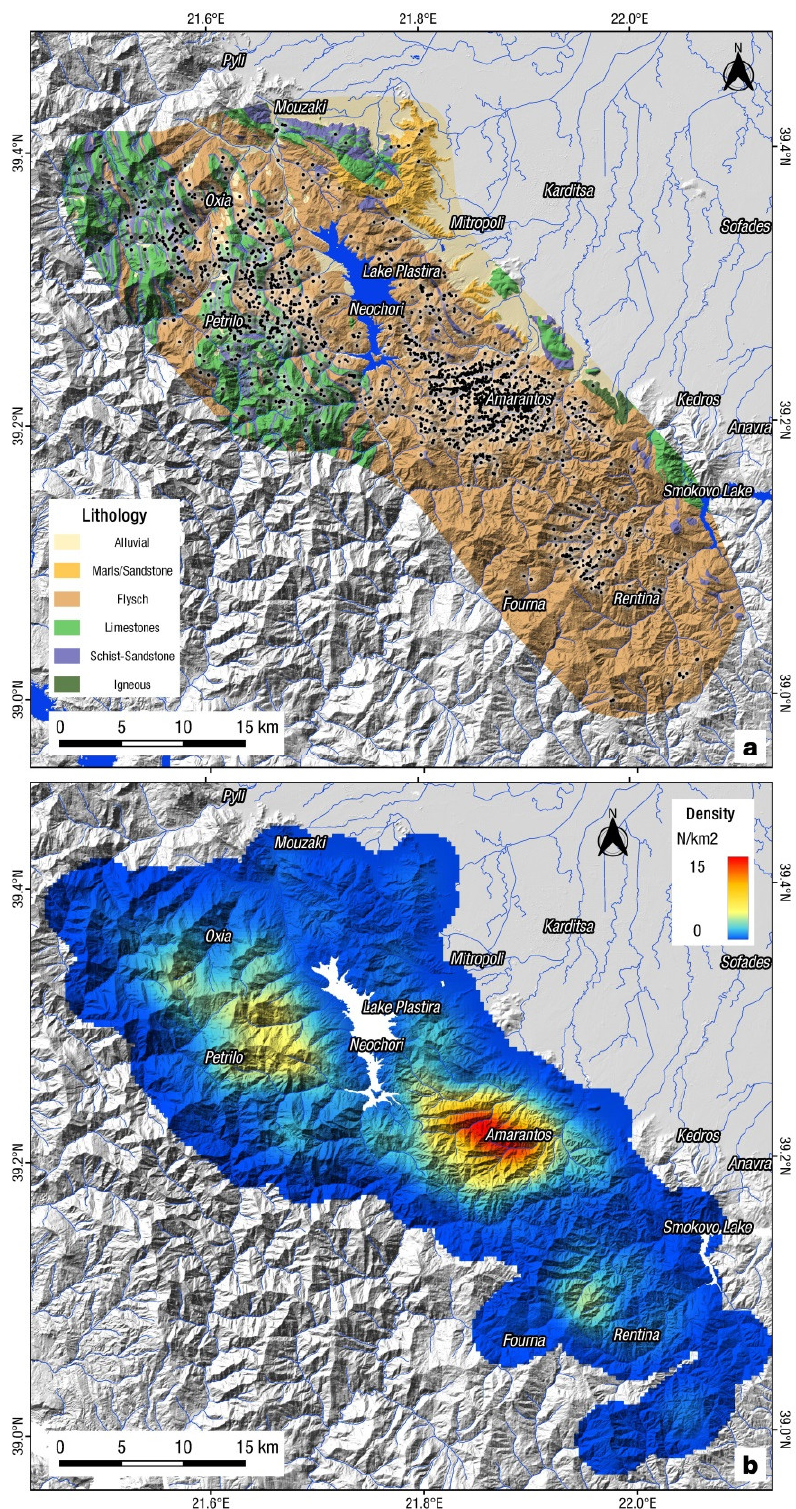
Figure 3. ( a ) Mapped landslides (black dots) triggered by Medicane Ianos during 17–19 September 2020, and simplified lithology of the area (see text for references). ( b ) Density map of Ianos landslides (using a radius of 1000 m); two major concentrations of landslides west of Lake Plastira and around Amarantos village.